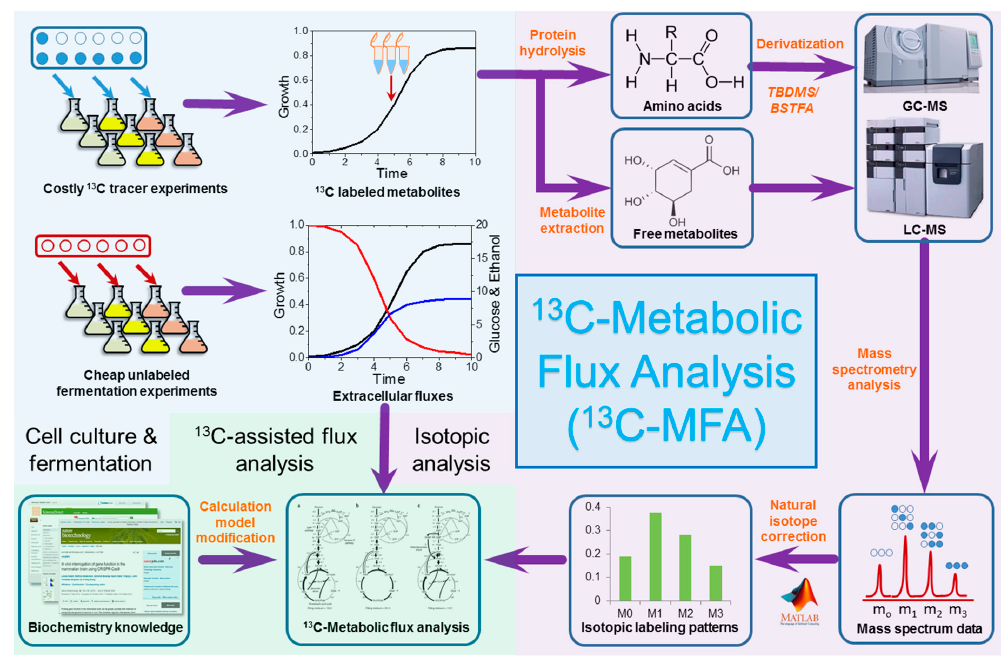
Figure 1 . The scheme of 13 C-Metabolic Flux Analysis ( 13 C-MFA). Figure 1. The scheme of 13 C-Metabolic Flux Analysis ( 13